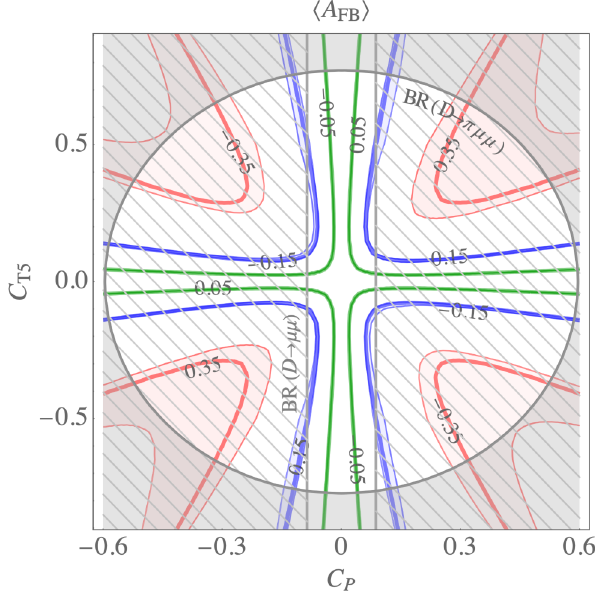
Figure 8 . Contours (blue, red, green) of the observable h A FB i , as defined in the text, in the C P – C T plane. The bands around the contours signify the theory uncertainty. The grey lines and shaded areas indicate the exclusion from the LHCb bounds on the branching ratios B ( D 0 → µ + µ − ) [52] and B ( D + → π + µ + µ − ) [38] as